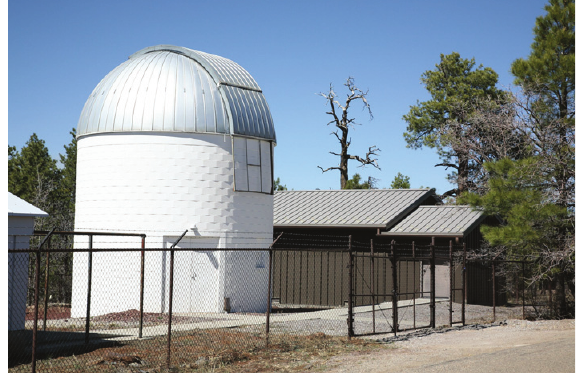
Figure 2: 31 (cid:3)(cid:3) dome and control